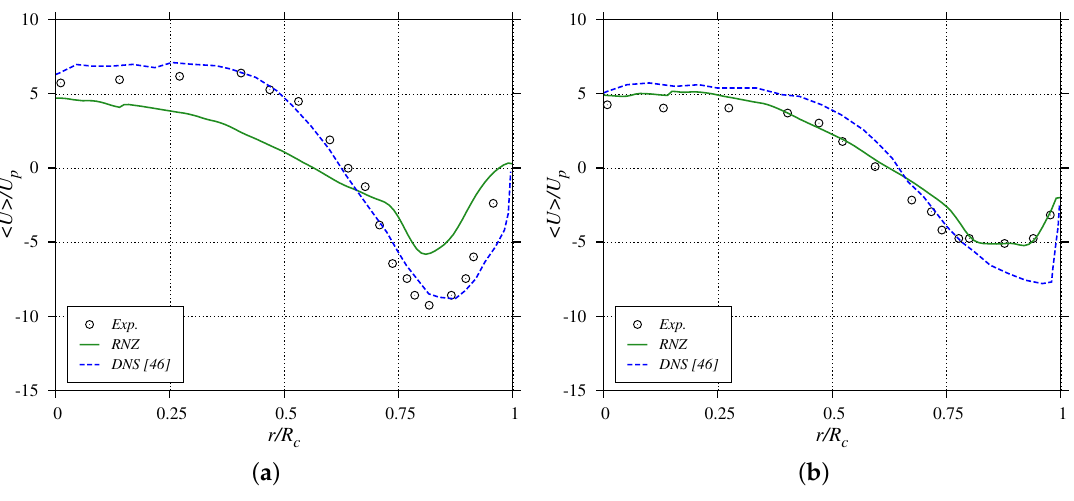
Figure 9. Radial distribution of the averaged axial velocity < U > at θ = 90 ◦ : ( a ) z = − 20 mm; ( b ) z = − 30